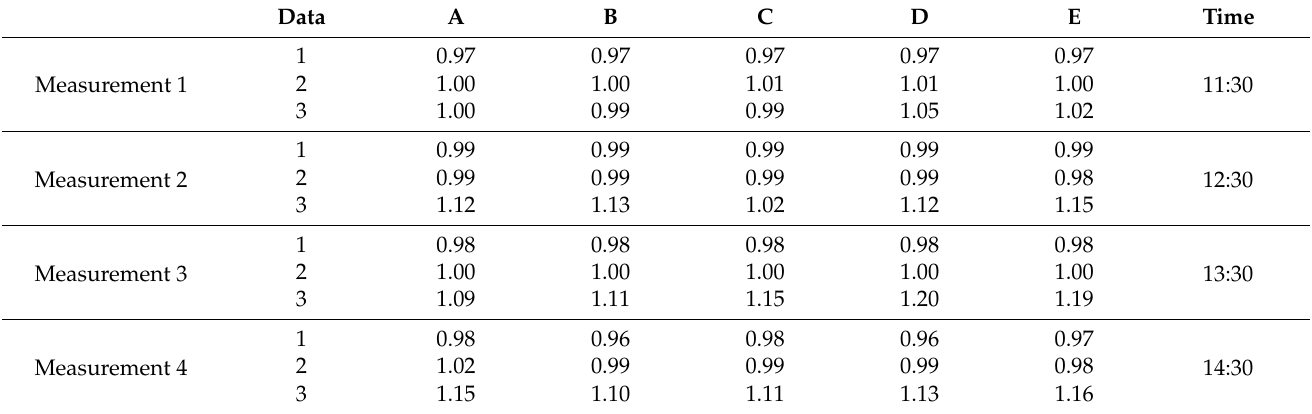
Table 4. Radiation ratios with galvanized steel canal and side panels with aluminum mirror installation.